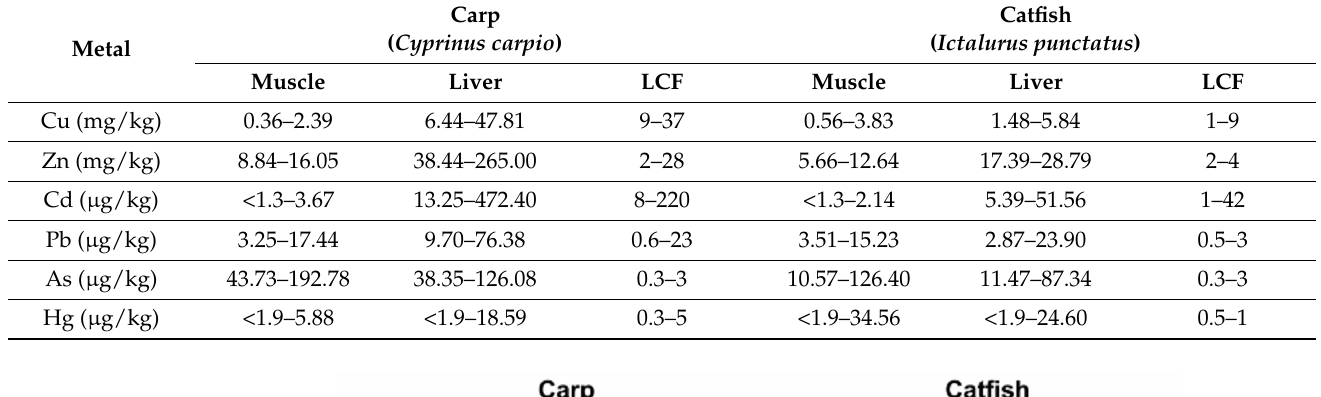
Table 3. Range of metal concentrations in muscle and liver of cultured fish, and range of liver concentration factor (LCF) by fish species in the experimental group along time.